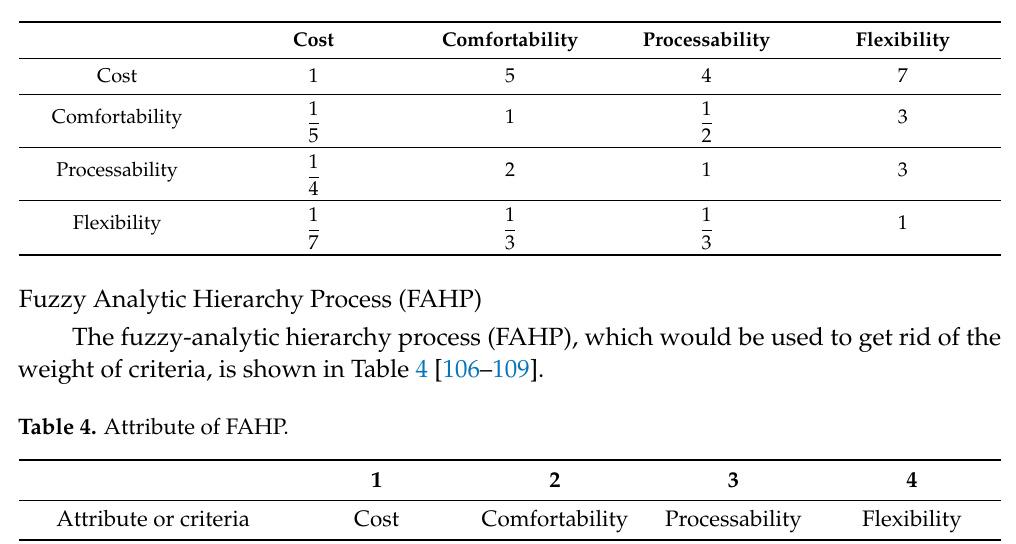
Table 3. Multi-criteria consideration.